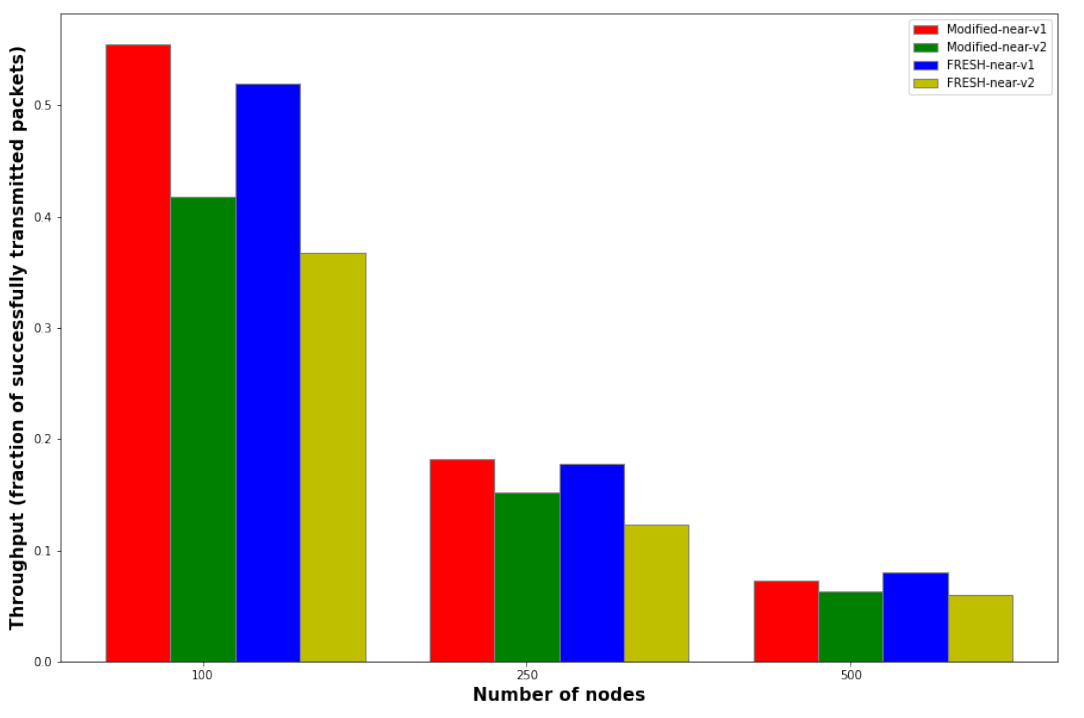
Figure 7. Dependence of throughput versus number of DTN nodes for Modified-near-v1, Modified- near-v2, FRESH-near-v1 and FRESH-near-v2